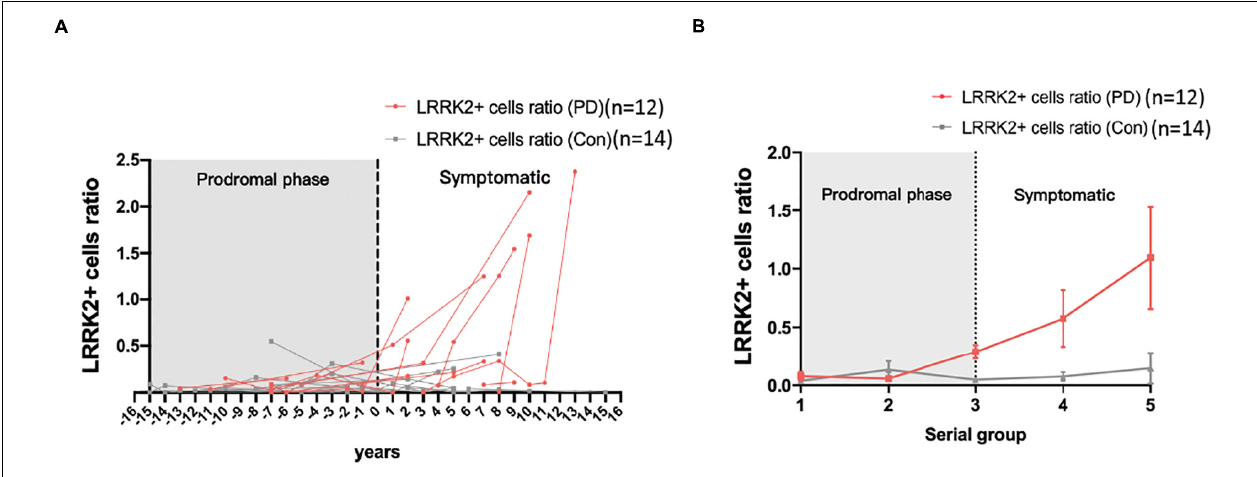
FIGURE 3 | Time-sequential serial analysis of LRRK2 expression in colonic biopsies from patients with PD and controls. (A) Individual data for colonic LRRK2 expression from the serial study. (B) Grouping analysis of colonic LRRK2 expression was significantly different between PD patients and controls in individual time serial